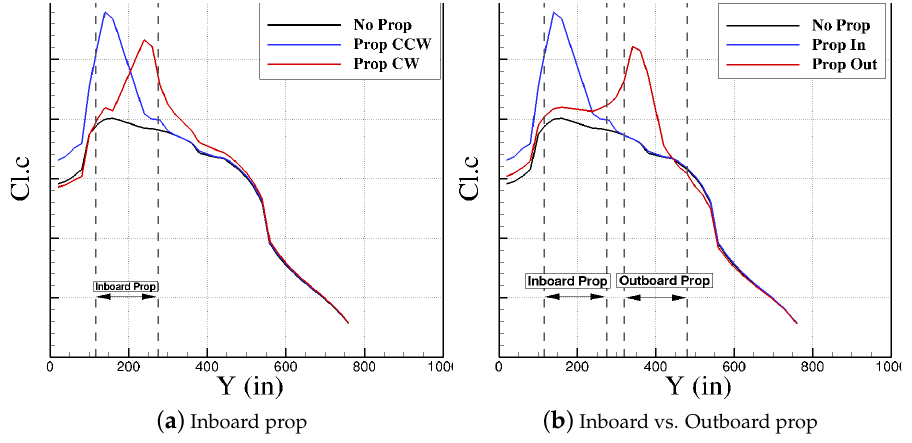
Figure 9. Local lift distribution for wing and propellers are installed inboard or outboard the wing. Propellers have a 20-deg blade angle. The inboard propellers spin either CW or CCW. In these figures, C l . c denotes the local lift times the local chord length. Local lift data are found from time-averaged